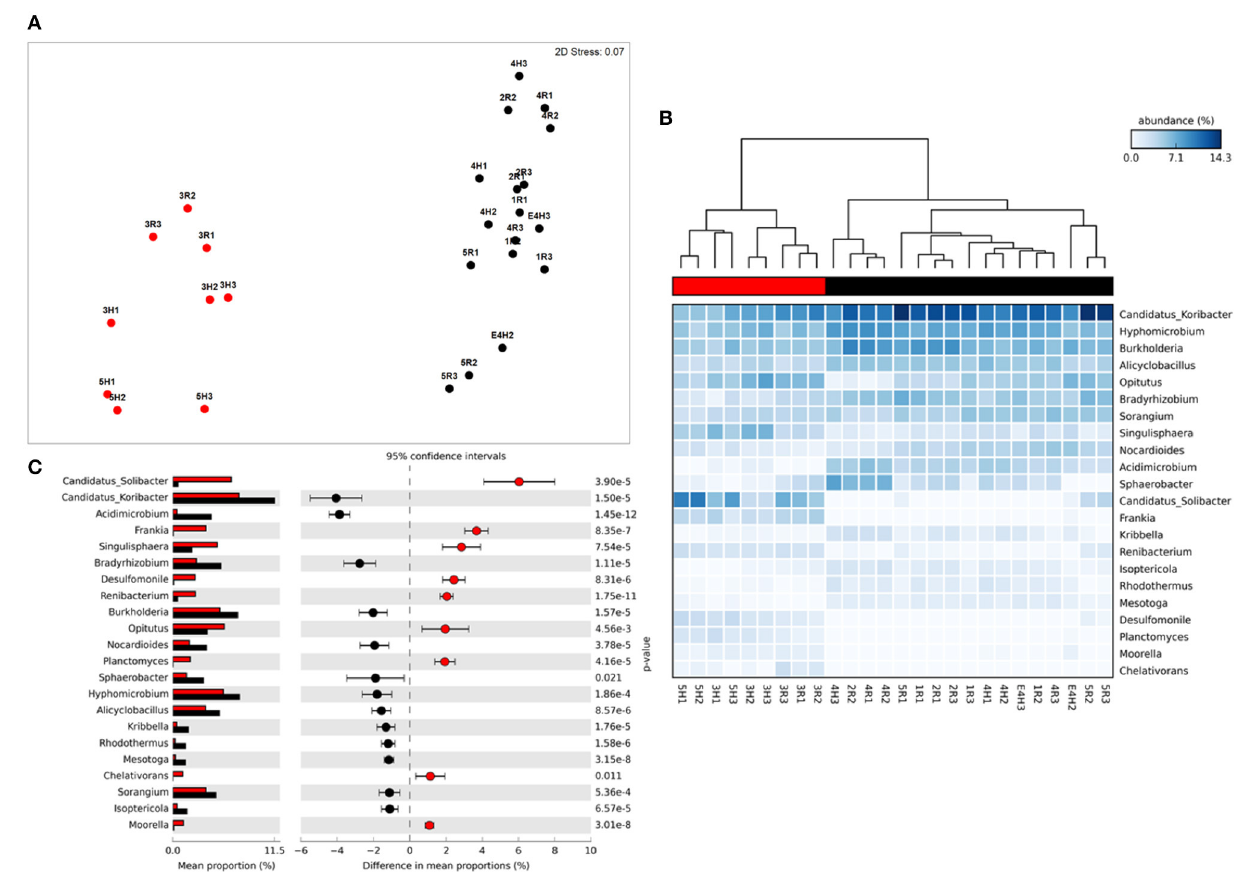
FIGURE 2 | Taxonomic metagenome profiles: (A) non-Metric Multidimensional Scaling (MDS) plot of taxonomic profile similarity (Bray-Curtis), (B) Heatmap of genera abundance with samples grouped by similarity (UMPGA clustering) and taxa ranked by mean abundance, (C) extended error bar plot of genera differentially abundant between sample clusters ( > 1% difference in abundance, p < 0.05, Welch’s t -test). Color of circles and dendrogram bar denotes sample grouping (Red, slow degrading; Black, rapid